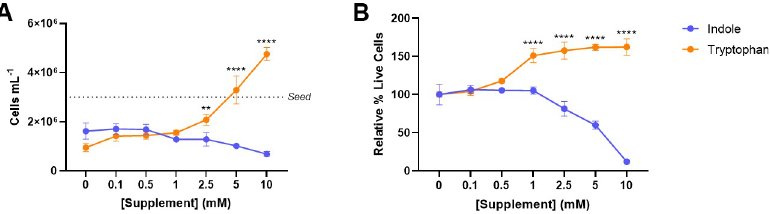
Fig 6. Indole and tryptophan have opposing effects on Blastocystis viability. 3 � 10 6 Blastocystis ST7-B were seeded in PBS supplemented with increasing concentrations of indole or tryptophan. A) Remaining number of live cells as determined by manual counting using a hemocytometer. Seed line indicates initial number of cells. B) Relative remaining proportion of live cells as determined by propidium iodide stain. Significance was calculated using a two- way ANOVA, with �� = p < 0.01 and ���� = p < 0.0001. N = 3 for all data points.